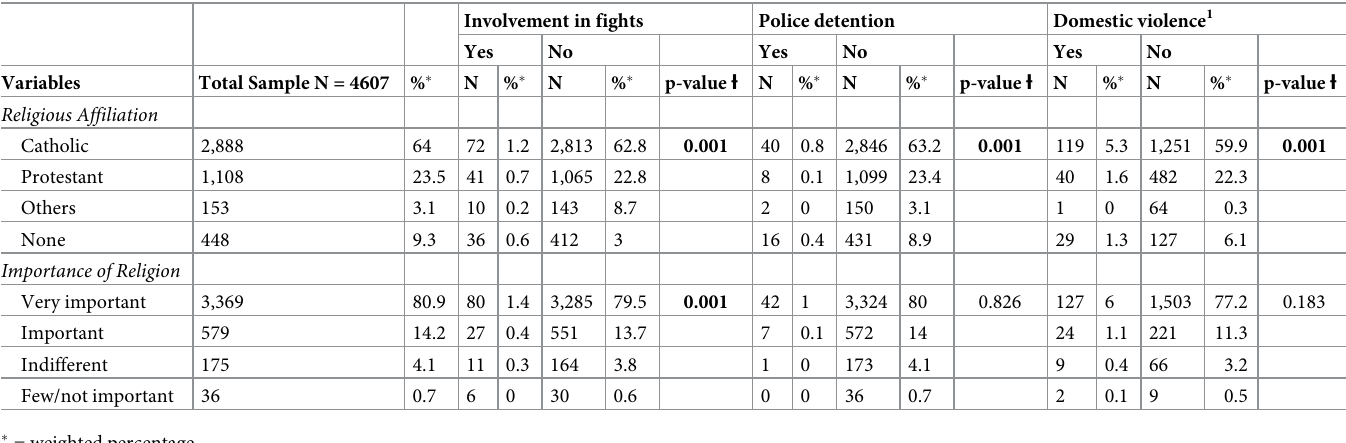
Table 2. Description of the religiosity on different outcomes of violence.